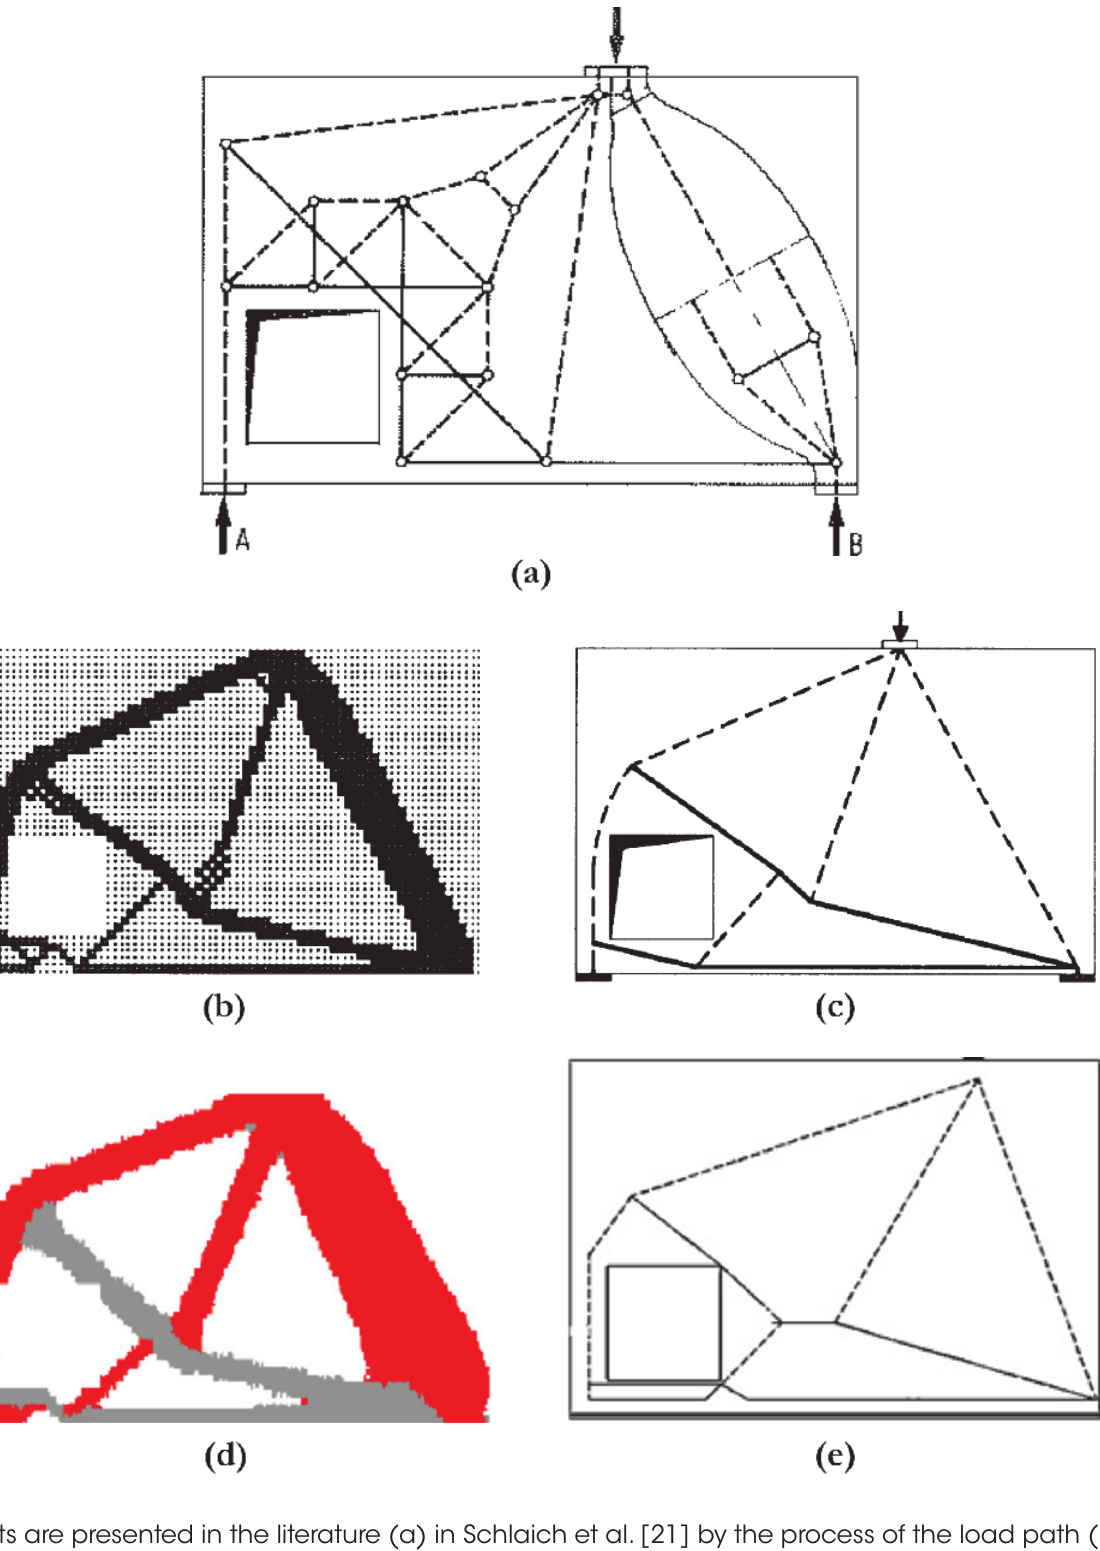
The results are presented in the literature (a) in Schlaich et al. [21] by the process of the load path (b) and (c) in Liang et al. [15] by the method ESO (d) and (e) in Almeida et al. [3] by the SESO method of topological